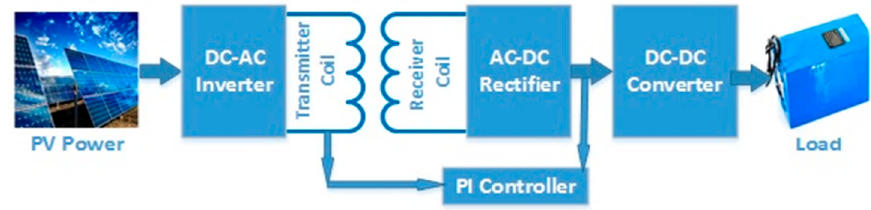
Figure 10. Schematic diagram for the overall system.